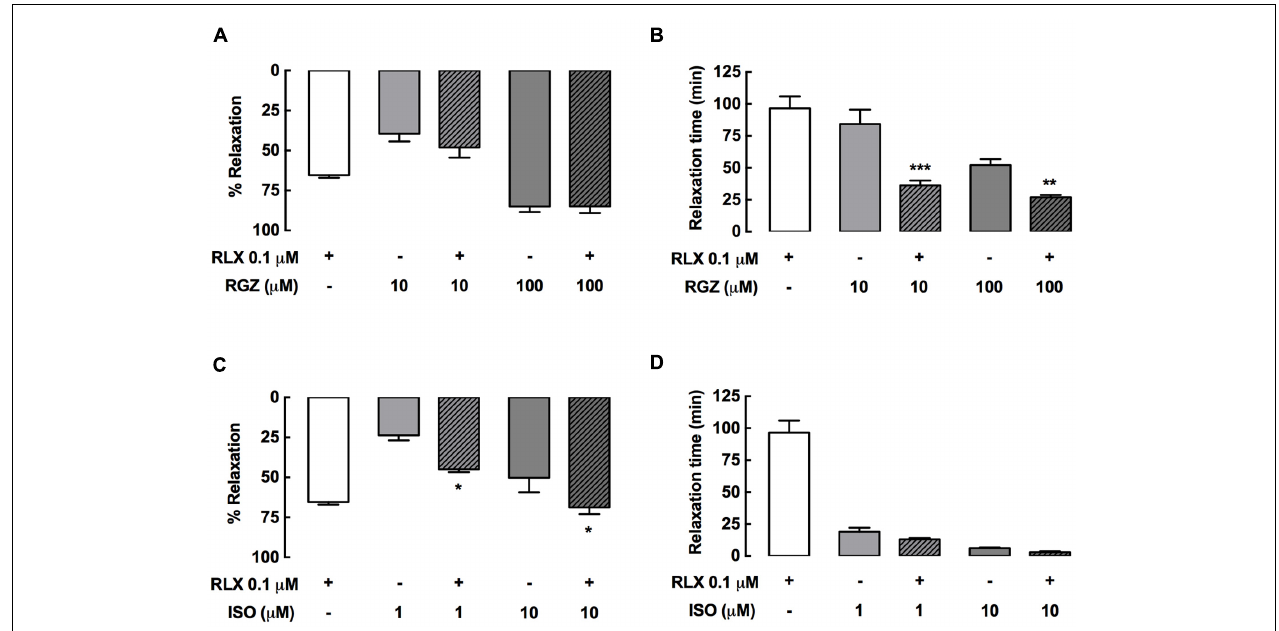
FIGURE 3 | rhRLX potentiates tracheal relaxation to RGZ and ISO. Rat trachea were precontracted with MCh, prior to measurement of (A,C) relaxation responses and (B,D) time to relaxation for rhRLX (RLX, 0.1 µ M), RGZ (10, 100 µ M) and ISO (0.1, 1 µ M) alone and in combination. Extent of relaxation is expressed as % of submaximal MCh pre-contraction, with relaxation time expressed in min (mean ± SEM for n = 4–5 per group). ∗ P < 0.05, ∗∗ P < 0.01, ∗∗∗ P < 0.001 vs. the matched concentration of RGZ or ISO